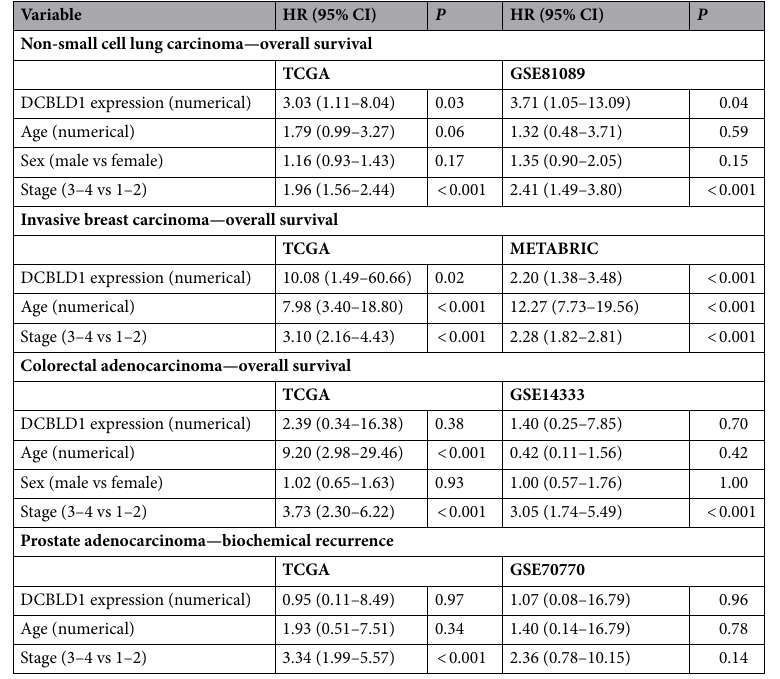
Table 2. Multivariate Cox proportional hazards analysis of cancer